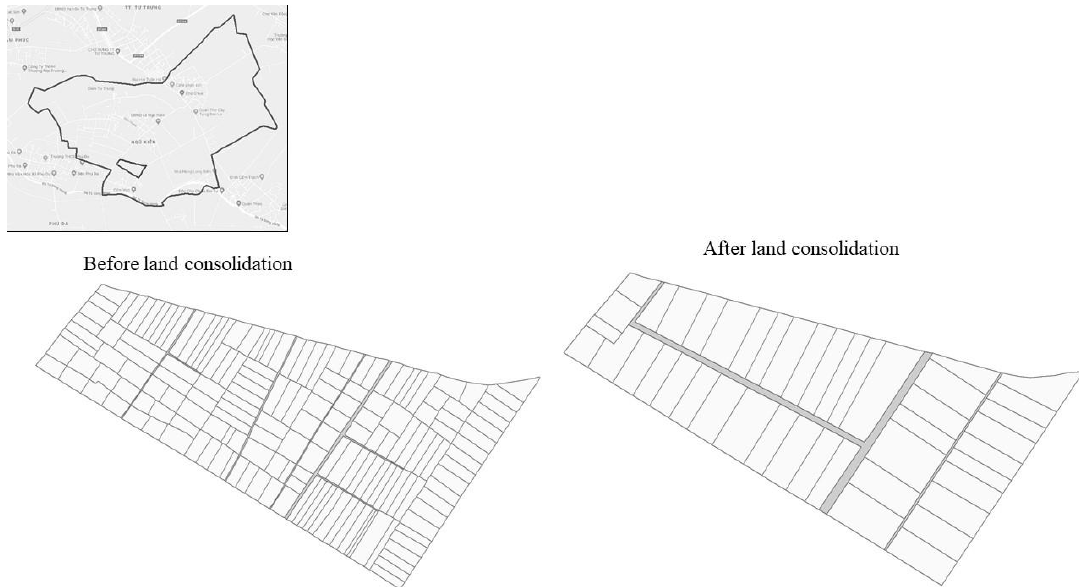
Figure 3. An example map of the pattern of agricultural land parcels before and after the latest land regrouping in Nhat Quang commune, Phu Cu District.